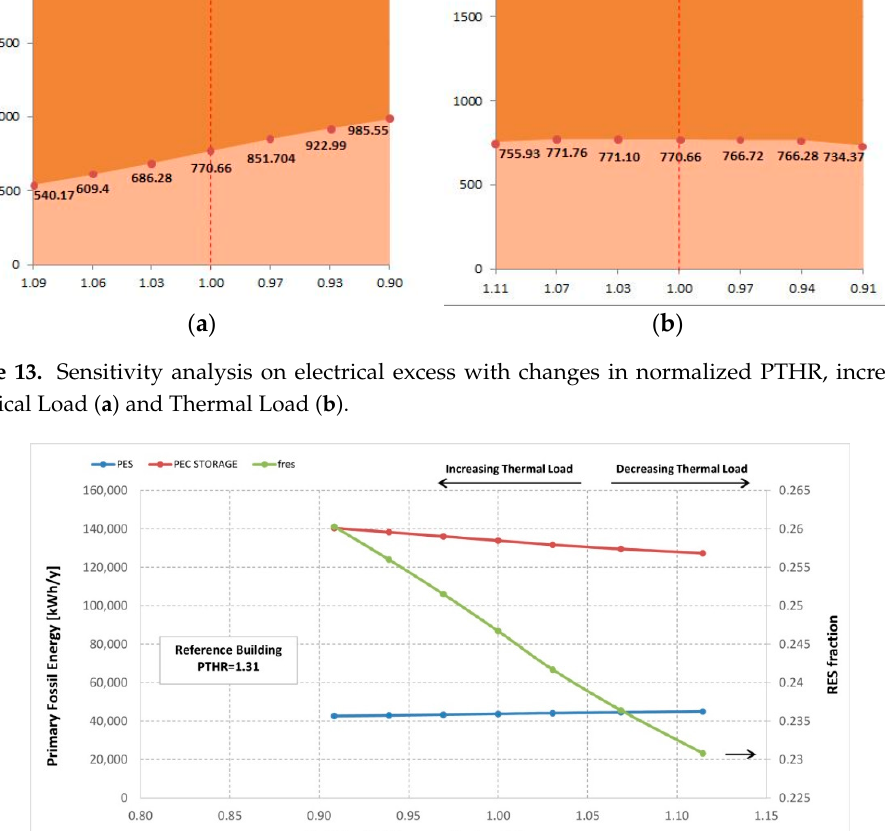
Figure 15. Sensitivity analysis on Performance indicators with changes in building Electrical loads, when a batteries bank is connected. Comparing the reference hybrid scenarios (i.e., building PTHR equal to 1), the hybrid system with the integrated electrical storage device shows a further reduction in primary fossil energy consumption starting from 140,583 kWh to 133,909 kWh. Given that the electricity excess is equal to 3503 kWh, the usable electricity from batteries is only 2802 kWh, because of the energy losses for charging and discharging process have been accounted for. As a consequence, it is possible to state that implementing complex hybrid systems along with storage represents a viable alternative option for lowering the dwellings primary fossil energy consumption. In such a way, a more effective and rational use of renewables can be attained, favouring the pathway towards the NZEB qualification associated to the existing buildings. Referring to Figures 14 and 15 it is noteworthy how the PEC reduction associated to the storage device application is higher when building PTHR is equal to 0.9. Indeed, in that case the computed benefit is 8163 kWh, whilst it is equal to 5218 kWh once the building PTHR is 1.09. Moreover, when the building PTHR changes owing to the thermal load variations the PEC trend line shifts down and its slope is basically constant. In the final analysis, the 3 case studies were compared through a histogram, showing the building primary energy need in the case of the traditional system, the hybrid system and the hybrid system with storage. The use of a high-performance energy generation system reduces energy requirements by almost 50%, as shown in Figure 16. Figure 16b represents the primary energy requirement according to the legislative decree 192/05 implementing the directive 2002/91 of the European Community [42]. The energy certification system provides that the lighting and driving force contribution is not counted in energy consumption, showing a significantly lower